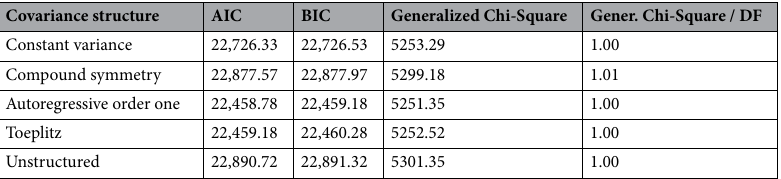
Table 4. Summarized value of Information criteria for 191 type 2 diabetes mellitus patients with 1740 glycimic control status observations at DMRH and FHRH, December 2014–December